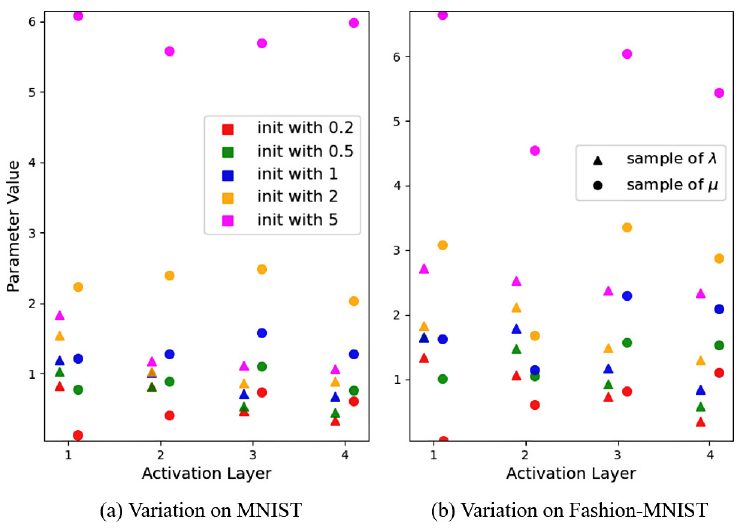
Figure 7. Parameter variation from different initialization on MNIST and Fashion-MNIST after learning. Triangular points are samples of λ and circular ones are samples of µ . Initial values are distinguished by different